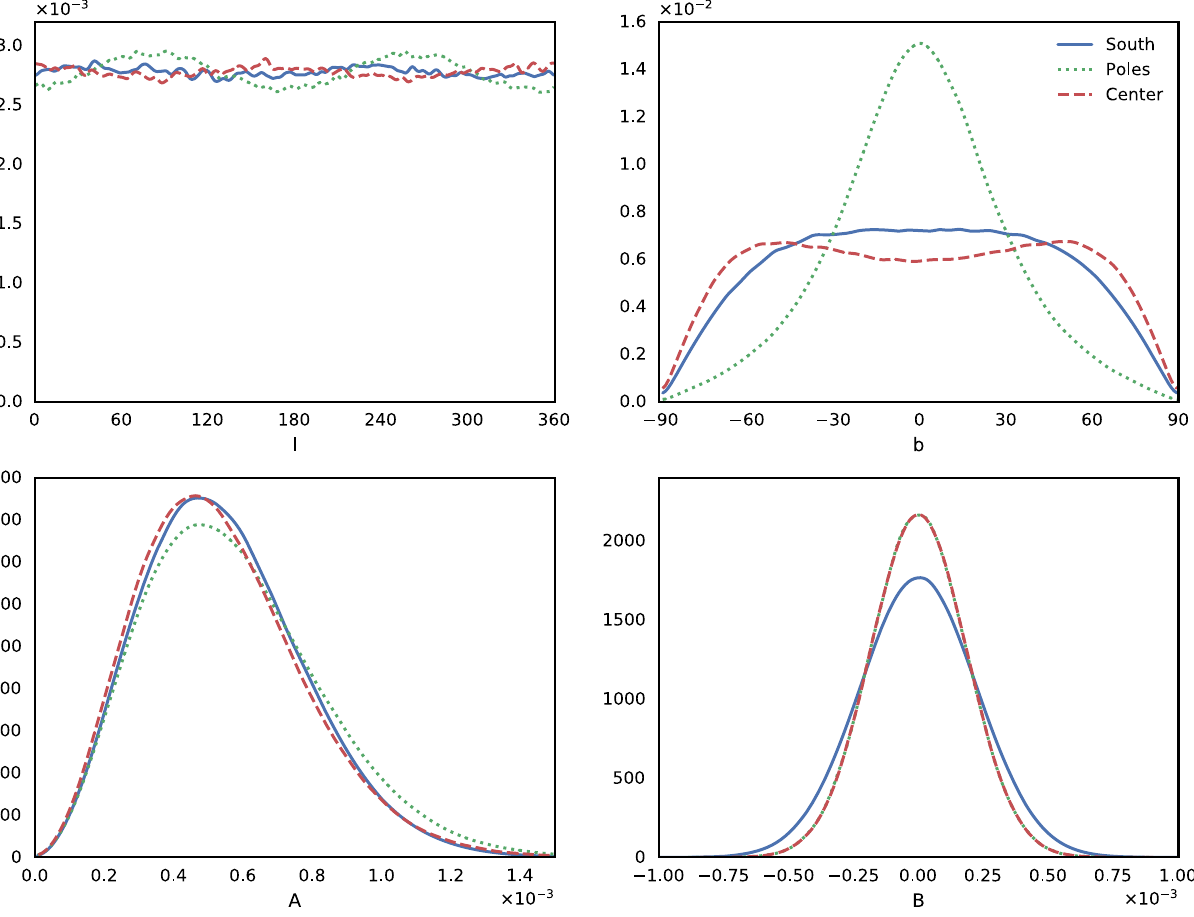
Fig. 19 Probability distributions of three synthetic data sets with a specific coordinate distribution